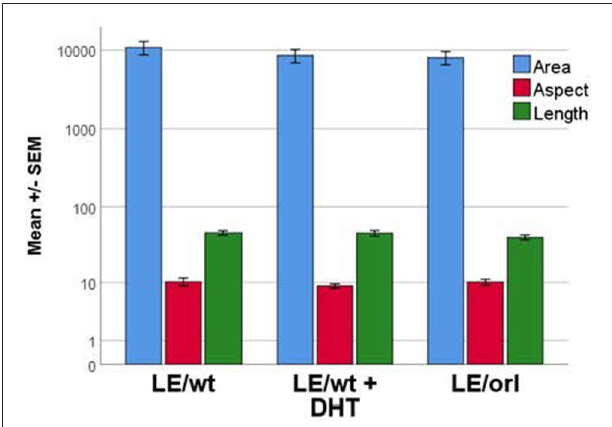
FIGURE 3 | Confocal volumes of AR immunostaining in LE/wt and LE/orl gubernacula ( n = 3–8). The volumes were segmented into “tip” regions immediately inferior to the cord, and “core” regions of the mesenchymal bulk. In all cases, the tip region trended toward increased mean staining intensity, and this trend was significant in E21 LE/wt (* p < 0.05) and approached significance in E17 LE/wt (# p = 0.06) analyses. We did not observe increased AR expression at the tip relative to other regions in LE/orl gubernacula.